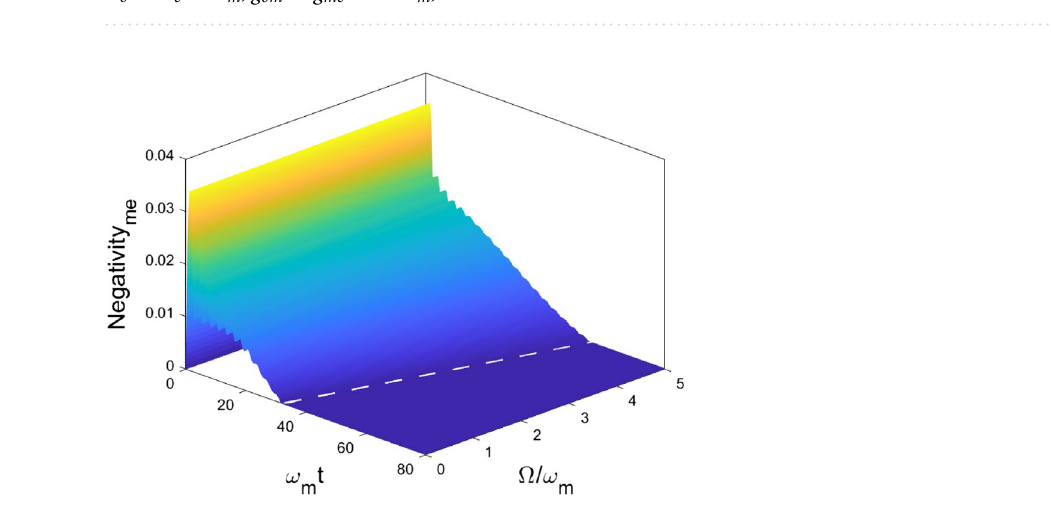
Figure 9. Dynamics of entanglement between ME, for different (cid:31) values. The dashed line marks the time that entanglement sudden death happens. It shows that the time to observe ESD has a linear relationship with the central frequency of the environment (cid:31) . Other parameters are chosen as ω o = ω e = ω m , g om = g me = 0.1 ω m , Ŵ = 1